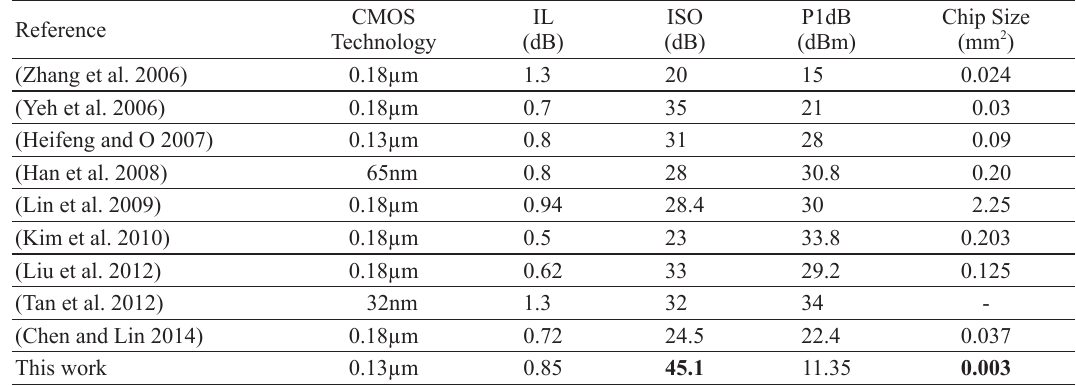
Comparison of T/R switch